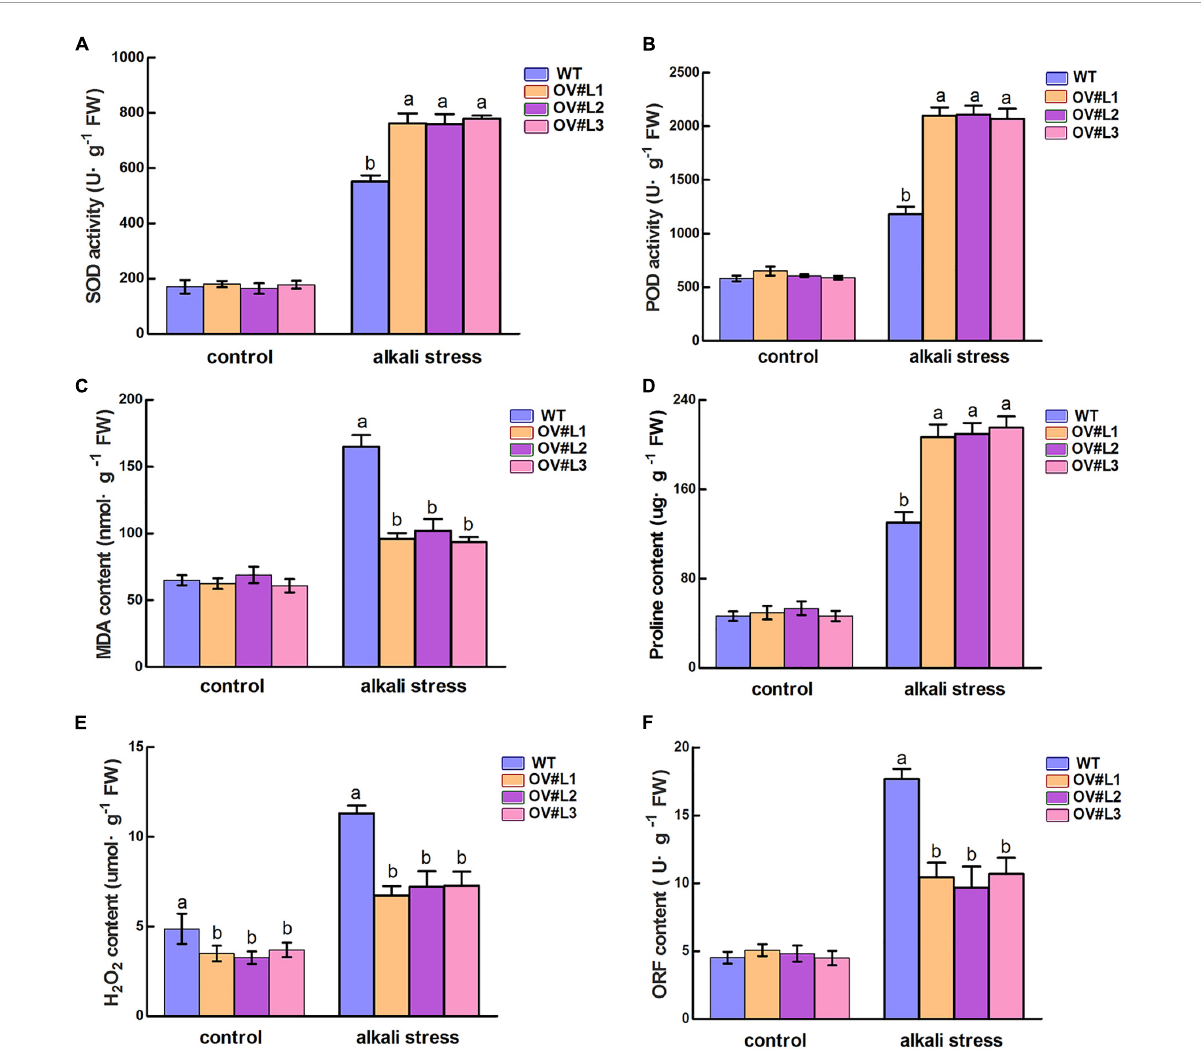
FIGURE4 Physiological index analysis of transgenic and wild-type plants under 5-day alkali stress treatment. (A) Superoxide dismutase (SOD) activity. (B) Peroxidase (POD) activity. (C) MDA activity. (D) Free proline content. (E) H 2 O 2 content. (F) OFR content. Each value is the mean ± SE of three biological replicates. Significant differences by different letters above the bars at the P < 0.05 and P < 0.01 level according to Duncan’s multiple range